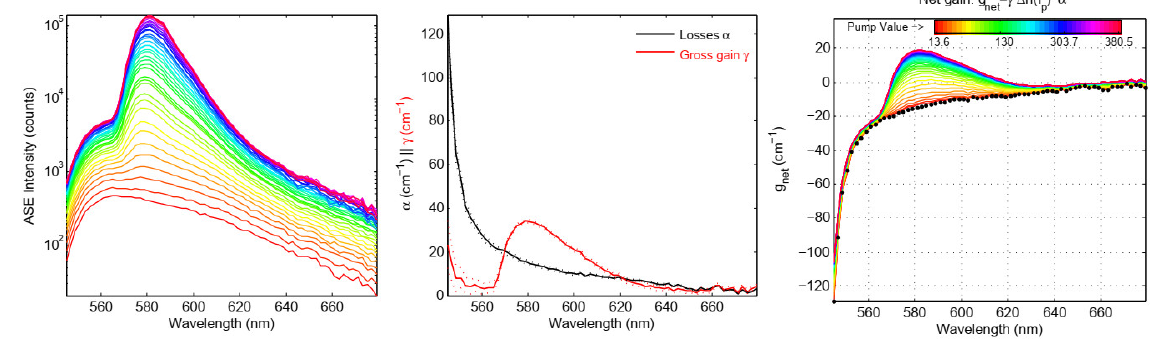
Fig. 1 (Left panel) ASE spectra as a function of pump intensity used for the fit. (Centre panel) Fitted losses α and gross gain γ as a function of wavelength. (Right panel) Spectrally resolved net optical gain at increasing pump